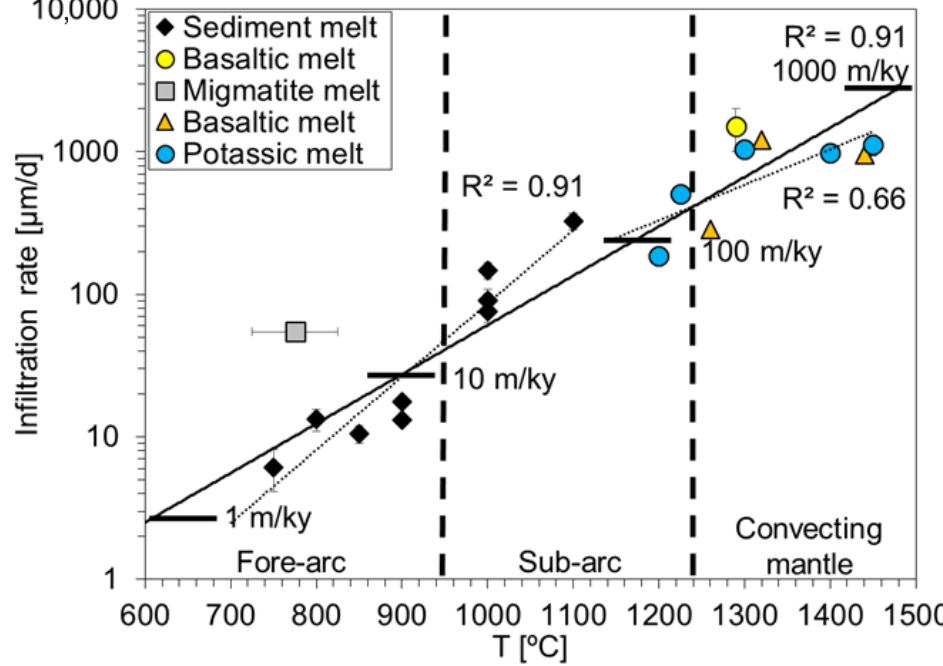
Figure 5. Rates of metasomatism. Daily metasome growth by infiltrating a reacting sediment melt (black diamonds in this study) and infiltration of potassic melt per day (blue circles, [37,53]) in other reaction experiments correlates exponentially with temperature. Rates of metasomatism are about 10–300 µ m/d, which translates to 3–100 m/ky. At fore-arc temperatures (<950 °C), typical rates of infiltration of reacting siliceous melt are 3–5 m/ky, which is an order of magnitude lower than values for estimates of melt extraction rates in migmatites during regional metamorphism (grey square, [59]). Infiltrating potassic melt lies about 1–2 magnitudes higher and reaches 200–500 m/ky, in accordance with values determined for basaltic melts (yellow circle [56], orange triangles [55]).